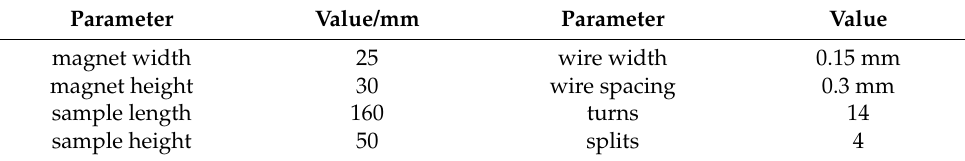
Figure 3. Schematic diagram for the design parameters of the angled SV wave EMAT. Table 1. Design parameters and values of angled SV wave EMAT. Table 1. Design parameters and values of angled SV wave EMAT.